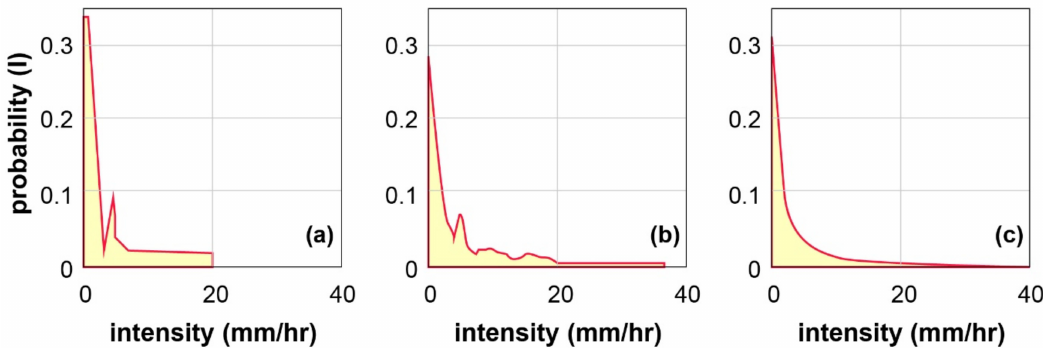
Figure 3. Distribution of the probability of rainfall intensity in three periods. The subpanels indicate the following: ( a ) 24 February–26 May 2011, representing the first period; ( b ) 26 May–3 August 2011, representing the second period; and 1991–2018, representing the last 28 years.